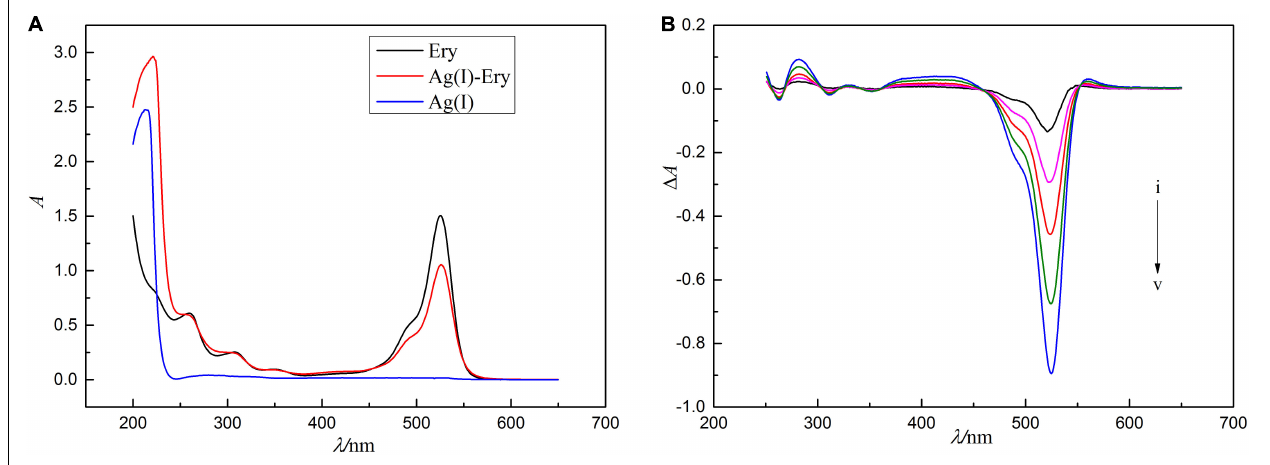
FIGURE 1 | Concentration of erythrosine is 1.0 × 10 − 5 mol/l, pH = 4.4. In panel (A) , the absorption spectrum was recorded by using water as a reference solution, the absorption spectra were measured using the reagent blank as the reference solution in panel (B) , and the concentrations of Ag(I) from curve i to v are 0.500, 0.625, 0.750, 0.875, and 1.00 µ g/ml.